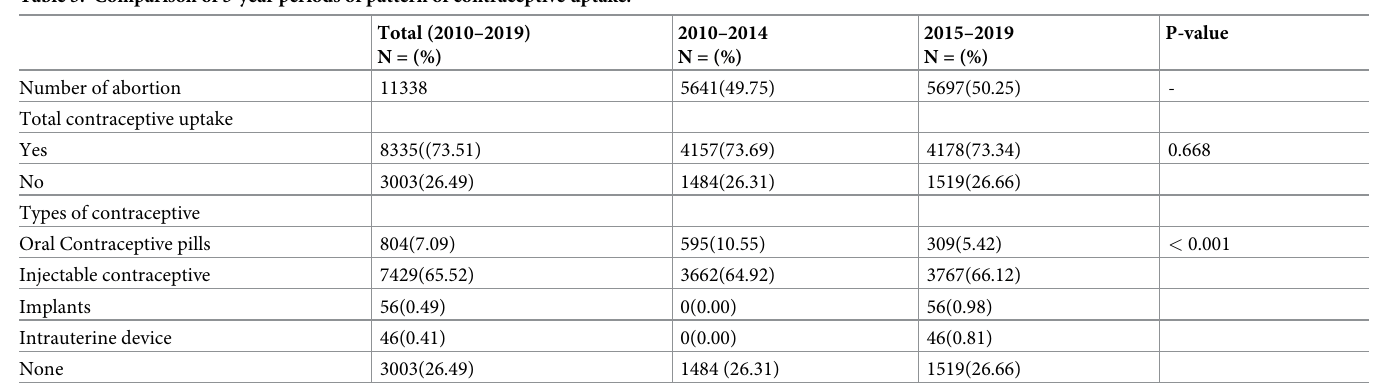
Table 3. Comparison of 5-year periods of pattern of contraceptive uptake.